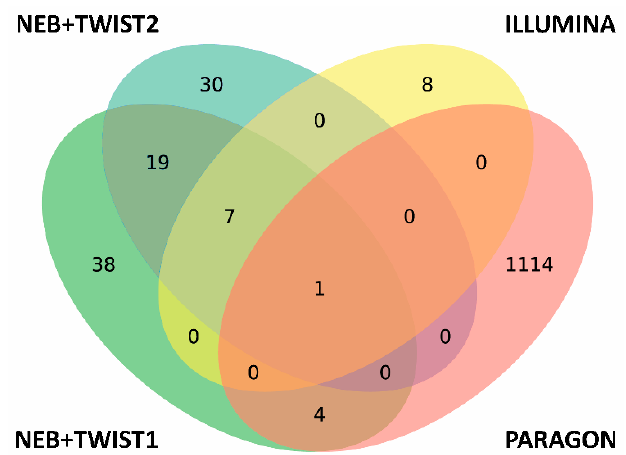
Figure 5. Venn diagram showing the distribution of variants (SNPs and InDels) among 4 experiments. In synthetic control samples processed in all four library preparation experiments (three approaches) the 19065T > C and 26144G > T variants at genomic location were common.